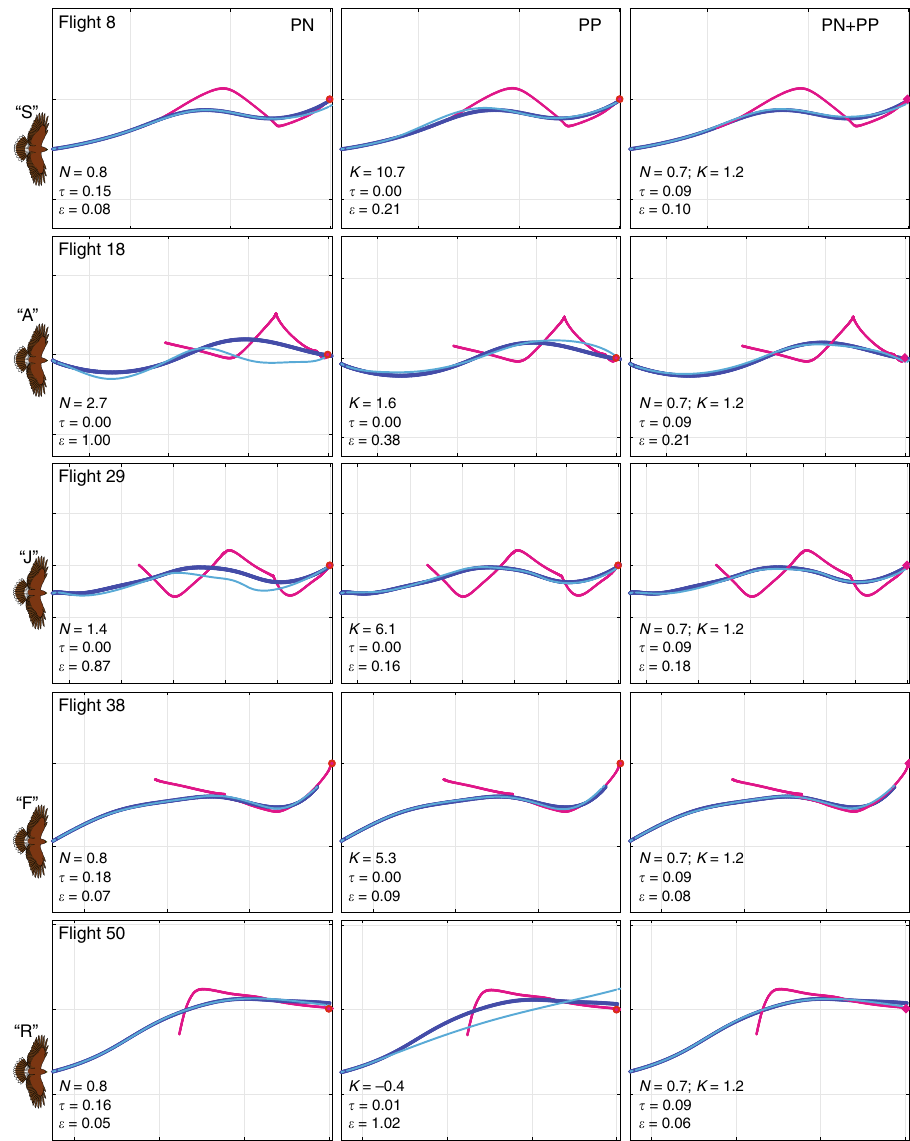
Fig. 4 Comparison of measured and simulated attack trajectories. Panels display measured attack trajectories (dark blue) and best- fi tting simulations (light blue) for each Harris ’ Hawk in pursuit of the lure (magenta), arranged by individual bird (rows) and by guidance law (columns; PN: proportional navigation; PP: proportional pursuit; PN + PP: mixed guidance law). The time delay τ (s) and guidance constant K (s − 1 ) or N are independently fi tted to each fl ight for PP and PN, but are globally fi tted to all fl ights for the mixed guidance law. For each bird, we display the fl ight with the least prediction error ε (m) under the mixed guidance law (excluding fl ights <20 m), to best show the complementarity of its PN and PP elements: whilst all fl ights are well-modelled by the globally fi tted mixed guidance law, some are not well-modelled by PN or PP, despite these being independently fi tted to each fl ight; see Supplementary Figs. 1 – 9 for all other fl ights. Grid spacing: 10